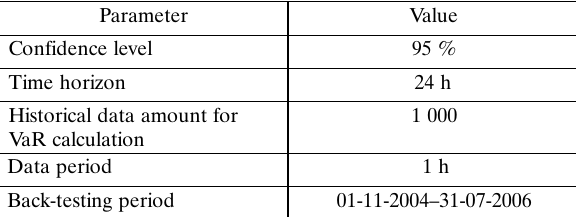
Table 1. Main parameters of back-tested model